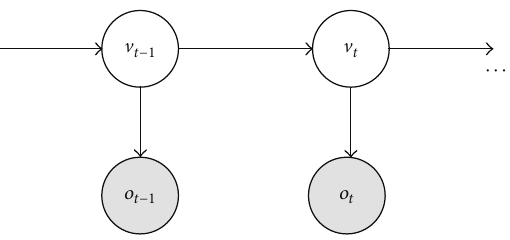
Figure 7: The HMM used for each person to estimate voice activity from visual cues. The hidden, binary variable V 𝑡 indicates if the per- son is speaking or not. The probability of V 𝑡 is estimated recursively using the previous estimate V 𝑡−1 and the current observation 𝑜 𝑡 .